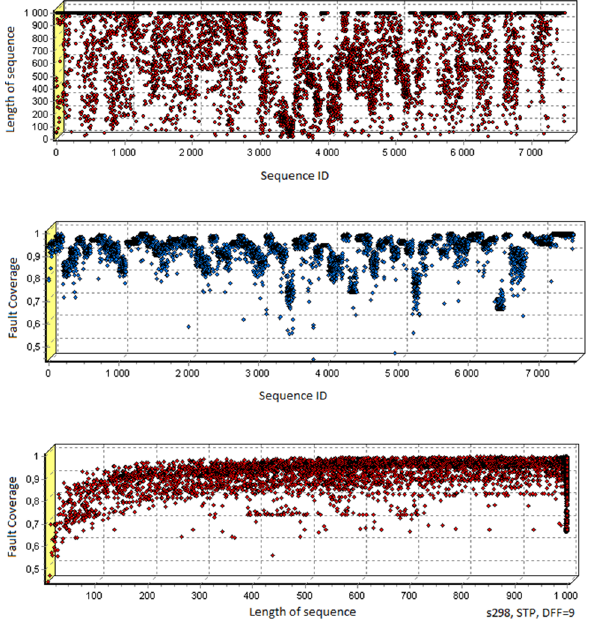
Fig. 30 STP for s298 with use of 9 internal flip-flops block of sequential circuit memory is not disconnected. In